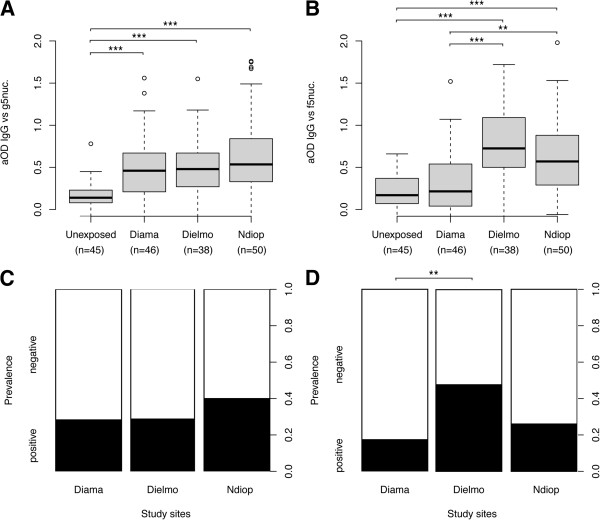
The IgG response and prevalence to g-5′nuc and f-5′nuc according to the level of mosquito bites and Anopheles populations (i.e.,proportion of mosquito species). Box plots of aOD values from unexposed (n = 45) and exposed (Diama, n = 46; Dielmo, n = 38 and Ndiop, n = 50) individuals to g-5′nuc (A) and f-5′nuc (B) proteins. Antibody responses are represented by aOD: the mean OD value of wells with recombinant salivary proteins minus the mean OD value of wells with coating buffer. The box plots display the median aOD value, 25th and 75th percentile. The whiskers indicate the 90th and 10th percentiles and the dots indicate the outliers. The P value was determined according to a Mann–Whitney U test (*, p <0.05; **, p <0.01; ***, p <0.001). The seroprevalence to g-5′nuc (C) and f-5′nuc (D) proteins in the four sites. The cut-off value for seropositivity (the mean aOD ± 3 standard deviations) was defined at 0.60 for g-5′nuc and 0.85 f-5′nuc, based on the IgG reactivity of sera from individuals living in Marseille that were not previously exposed to An. gambiae and An. funestus. Individuals showing aOD values above the cut-off level for seropositivity were classified as responders. The whiskers denote the 95% CI. The P values were determined by Pearson’s Chi-squared test (*, p <0.05; **, p <0.01; ***, p <0.001).